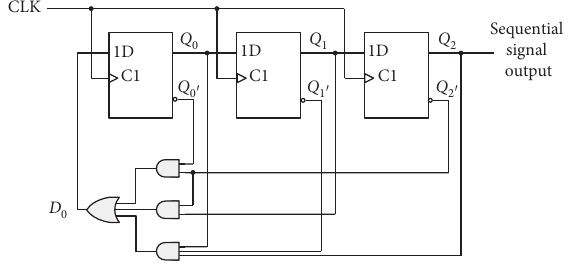
Figure 3: Signal generator based on shift register. Table 1: Circuit state